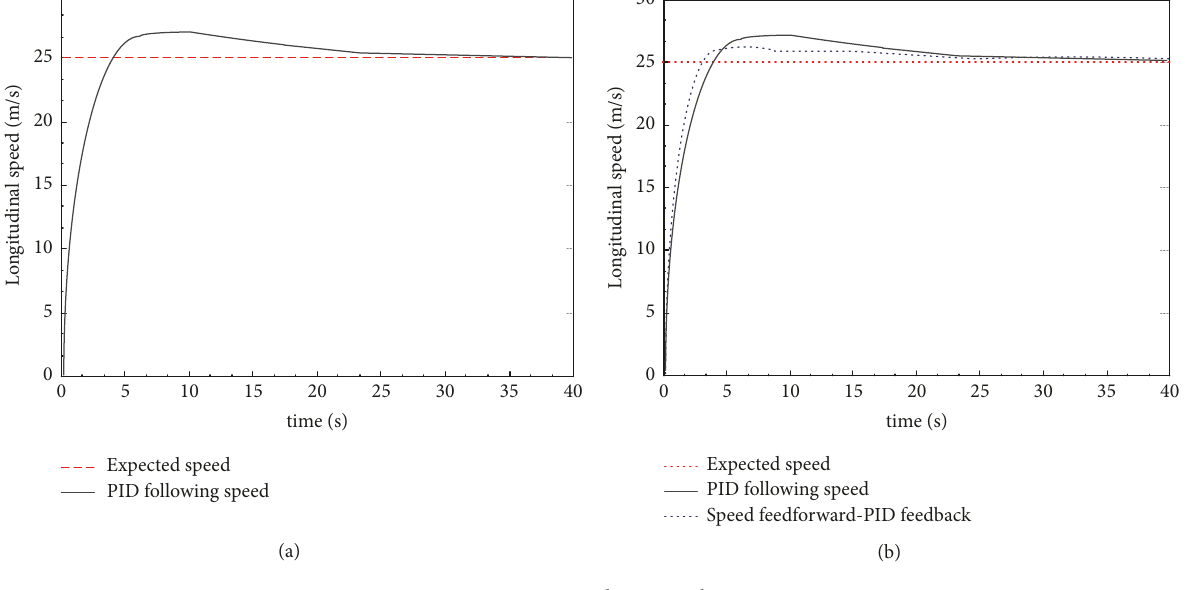
Figure 15: Simulation